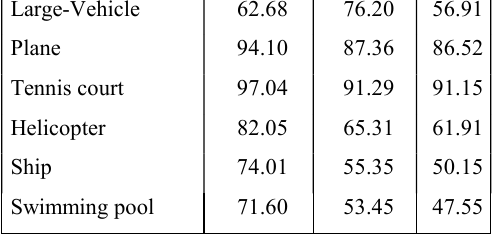
Table 2. Statistical results of the experimental. %